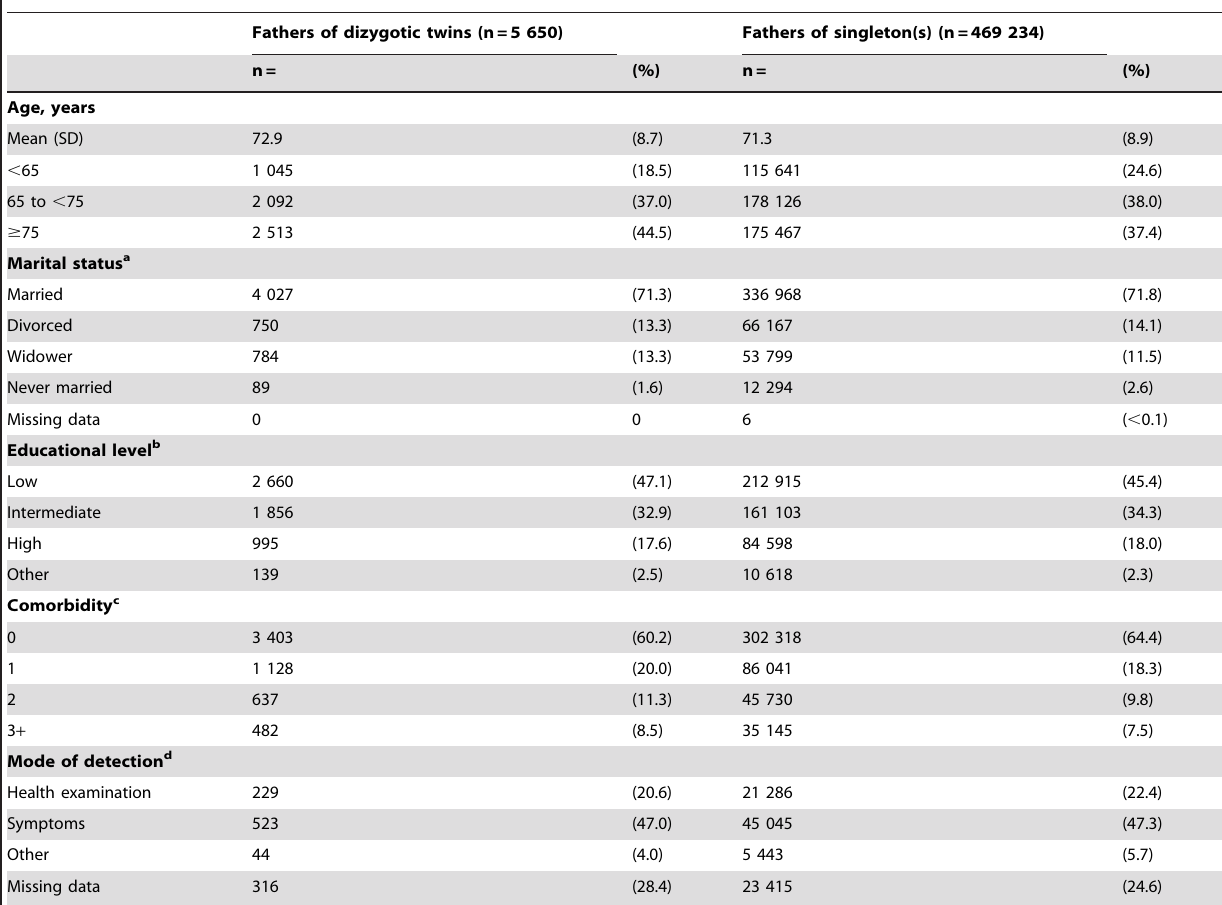
Table 2. Characteristics of dizygotic twin fathers and fathers of singleton(s) in Prostate Cancer database Sweden 2.0.